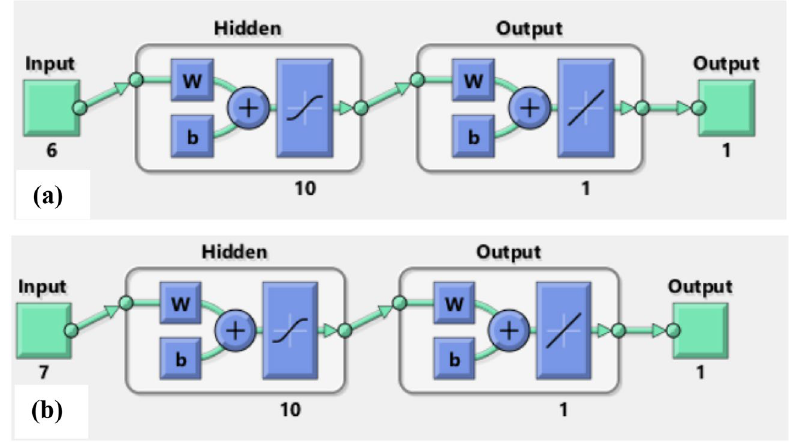
Figure 2. The architecture of ANN models. ( a ) Model 1. ( b ) Model